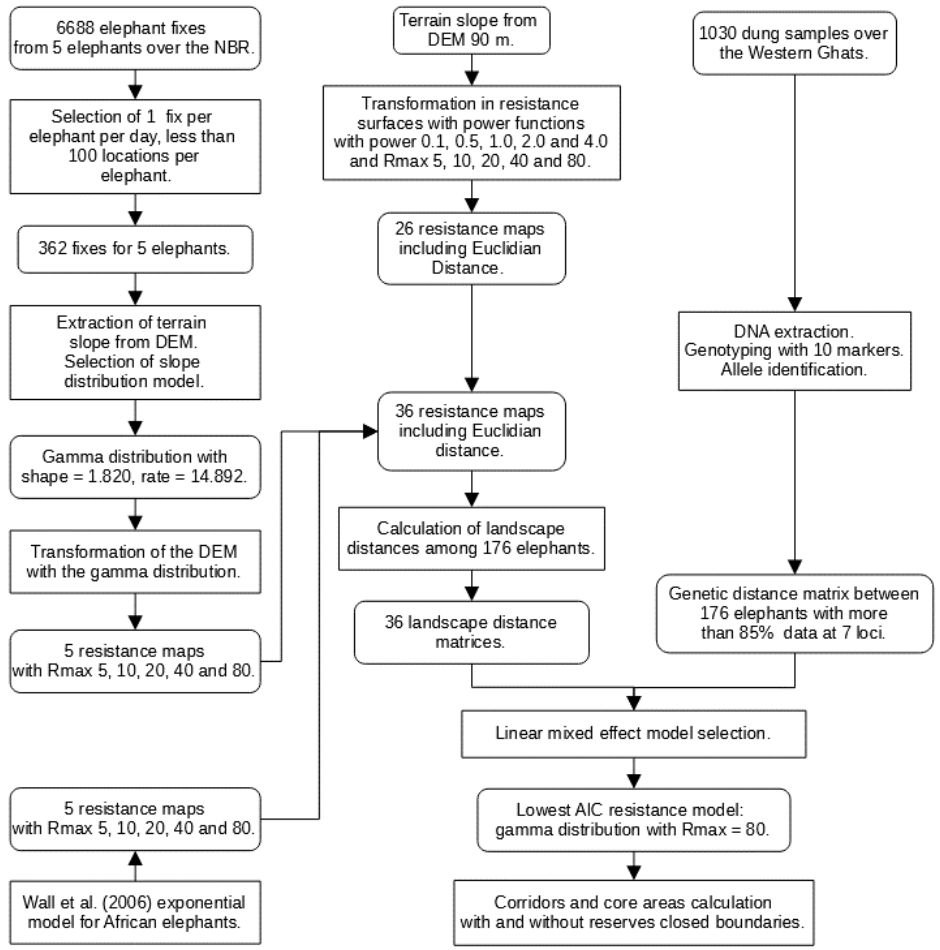
Figure 2. Method flowchart with the main components: (i) production of 36 resistance maps, (ii) calculation of landscape distance matrices, (iii) calculation of the genetic distance matrix, and (iv) calculation of core areas and corridors [11].